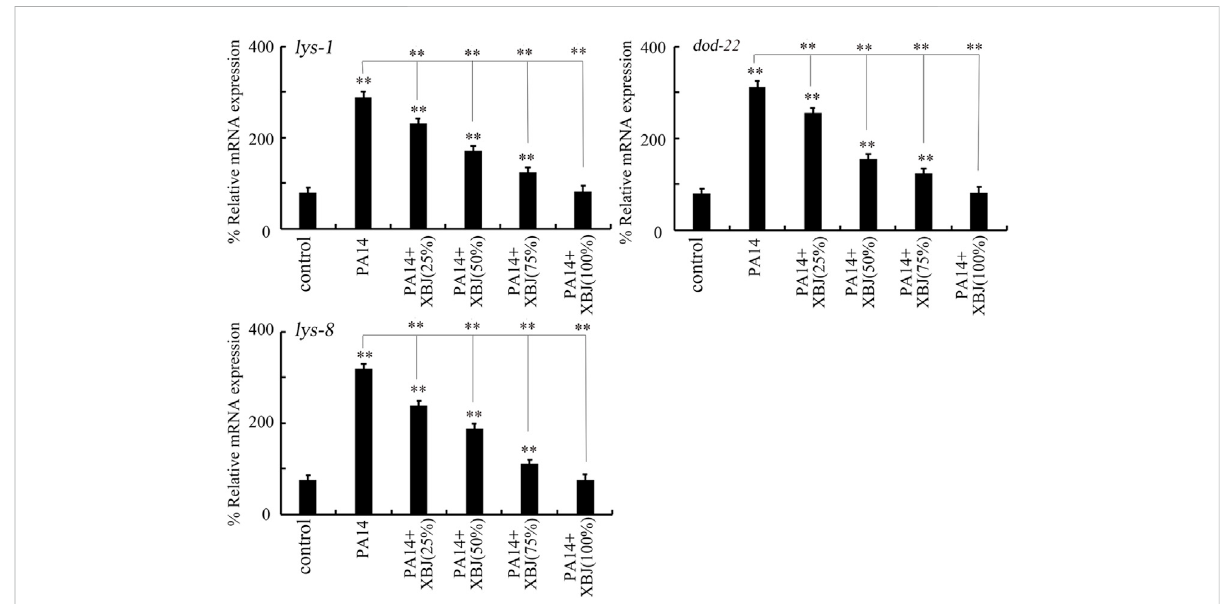
FIGURE 3 EffectofXuebijingpost-treatmentonantimicrobialgeneexpressionin P . aeruginosa -infectednematodes.XBJ,Xuebijing.** p < 0.01vs.control (if not specially indicated).